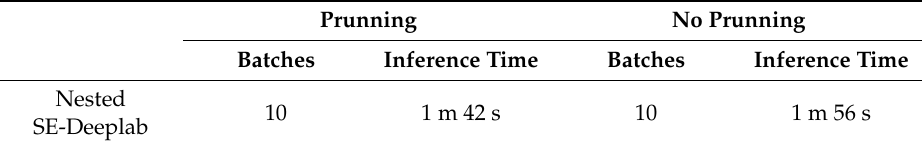
Table 5. Durations of two structures of Nested SE-Deeplab quantitatively